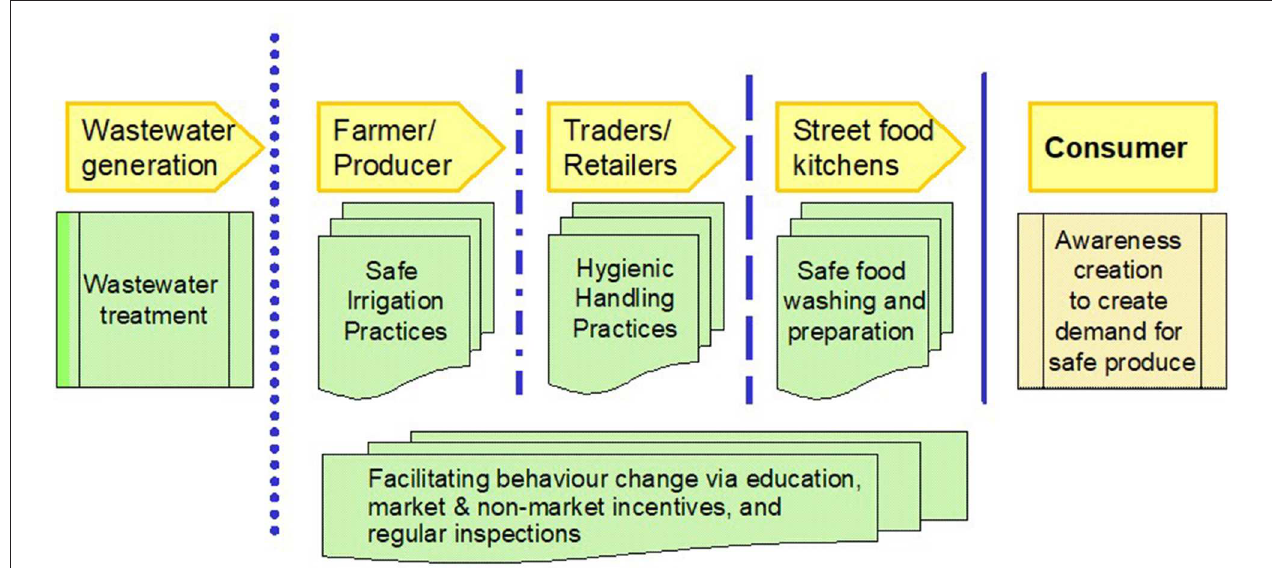
FIGURE 2 | Multi-Barrier Approach (Amoah et al.,